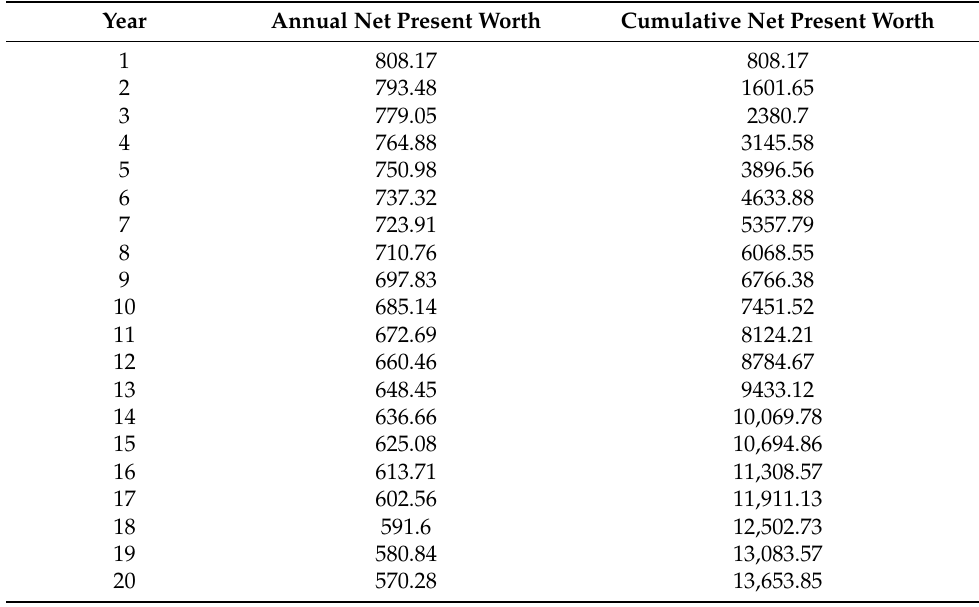
Table 6. Annual revenue diagram of Nanjing drying